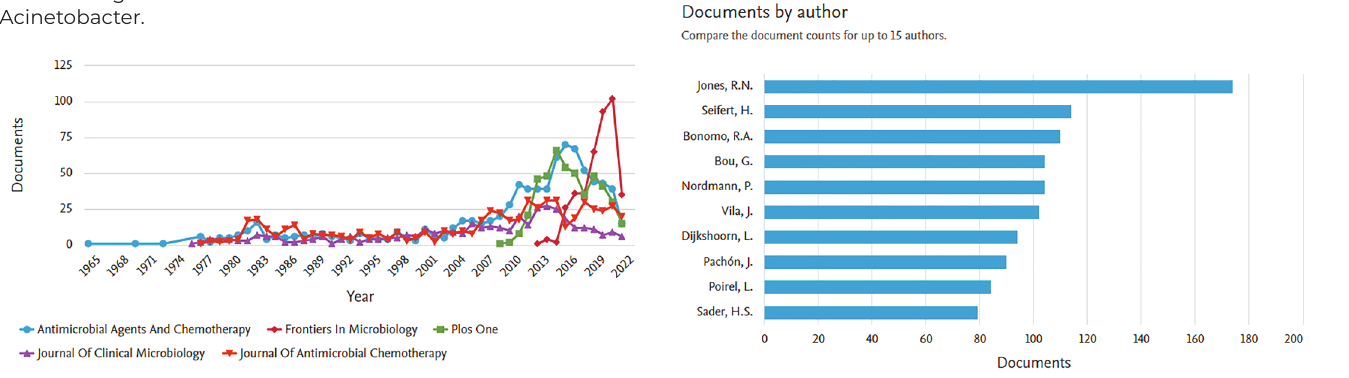
Figure 3 - Documents by authors.